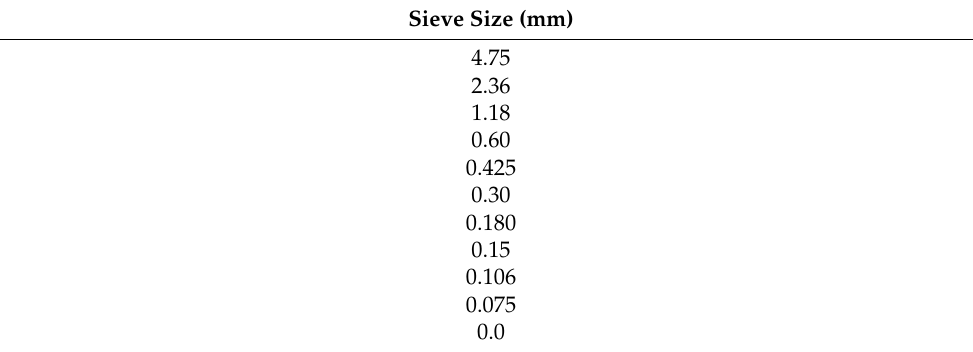
Table 3. Mechanical sieve opening diameter and numerical bin